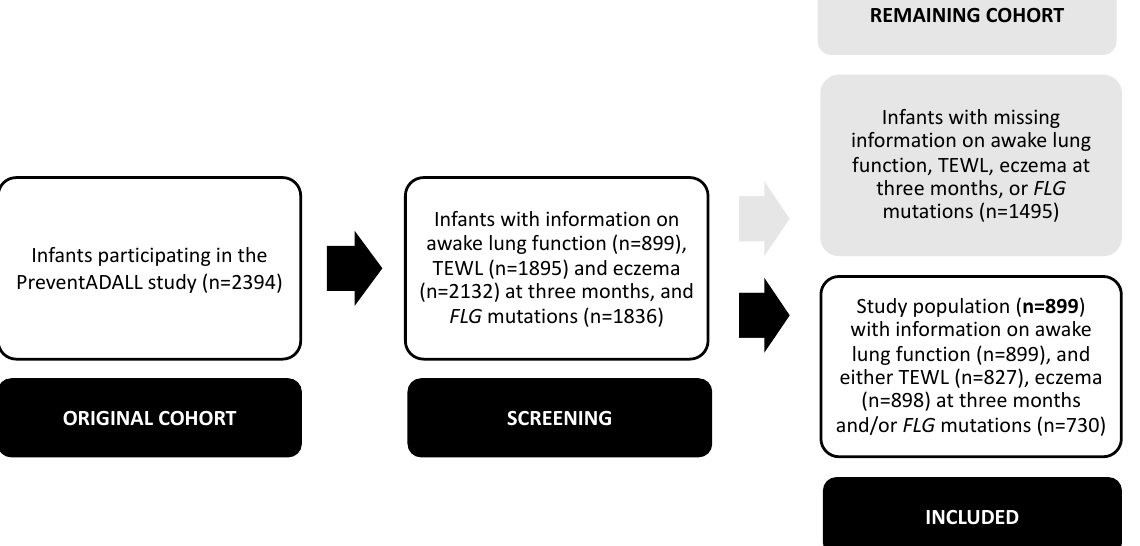
Figure 1. Flow chart of the study population (n = 899). PreventADALL: Preventing Atopic Dermatitis and ALLergies in children; TEWL: transepidermal water loss; FLG : Filaggrin. The 899 included infants were born at a mean ± SD GA of 40.1 ± 1.32 weeks and 439 (48.8%) were girls. Compared to the remaining cohort not included in this study, the included infants more often had parents with higher socioeconomic status, a lower mean TEWL and higher frequency of eczema, though similar rates of FLG mutation carriers. At three months of age, the mean TEWL among 827/899 (92.0%) included infants was 7.94 ± 5.66 g/m 2 /h, eczema was present in 135/898 (15.0%) and FLG mutations were identified in 73/730 (10.0%) infants (Table 1), evenly distributed between boys and girls (data not shown). The included infants had a mean ± SD t PTEF / t E of 0.39 ± 0.08. The infants with a lower t PTEF / t E (n = 48) had a mean t PTEF / t E of 0.23 ± 0.02 and a mean t PTEF of 0.16 ± 0.04. The infants with a lower t PTEF (n = 223) had a mean t PTEF / t E of 0.34 ± 0.08 and a mean t PTEF of 0.15 ± 0.01. The TFV loop parameters are further described in Supplementary Table S1. Table 1. Birth and background characteristics of the 899 included infants and the remaining cohort at three months of age. Characteristics